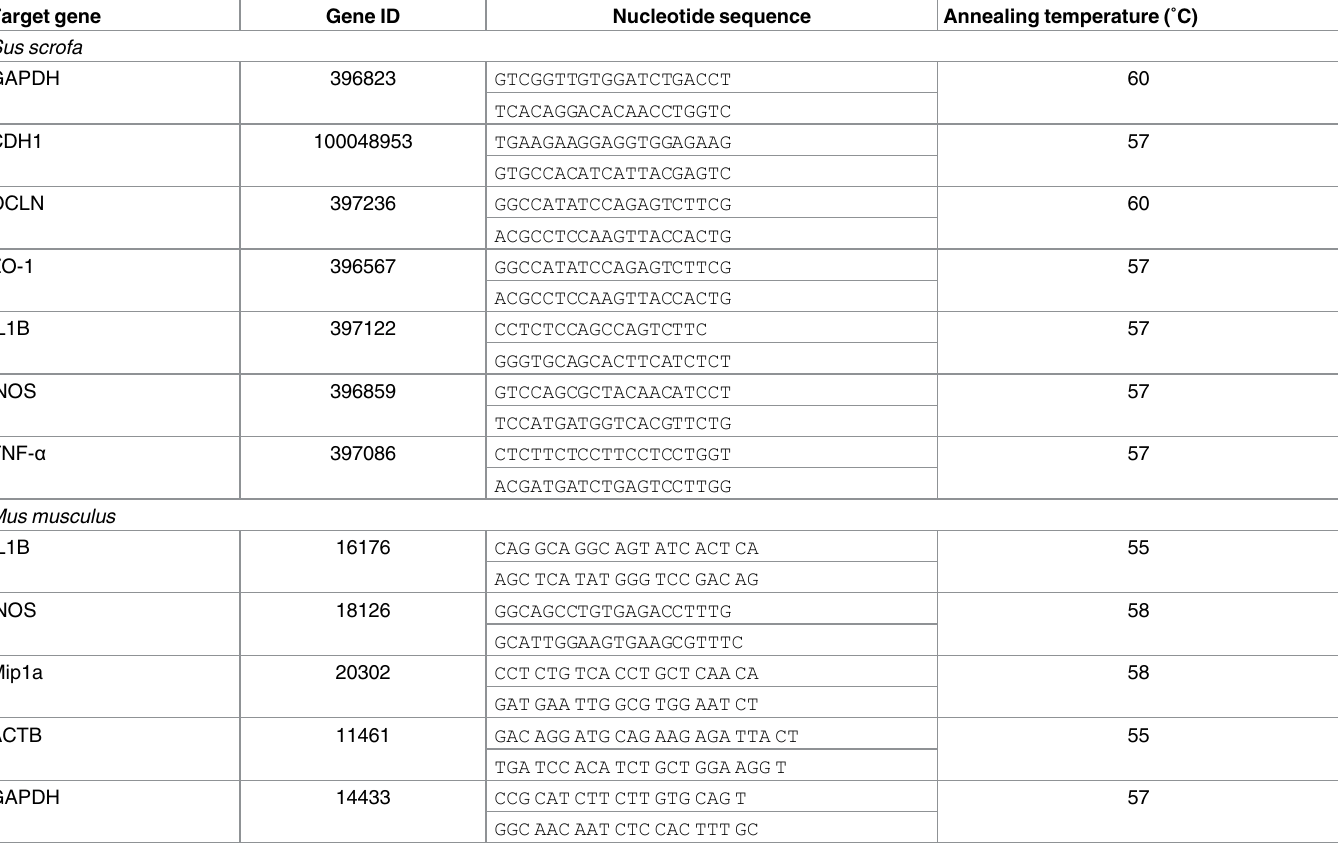
Table 3. Oligonucleotide sequences used to determine target gene